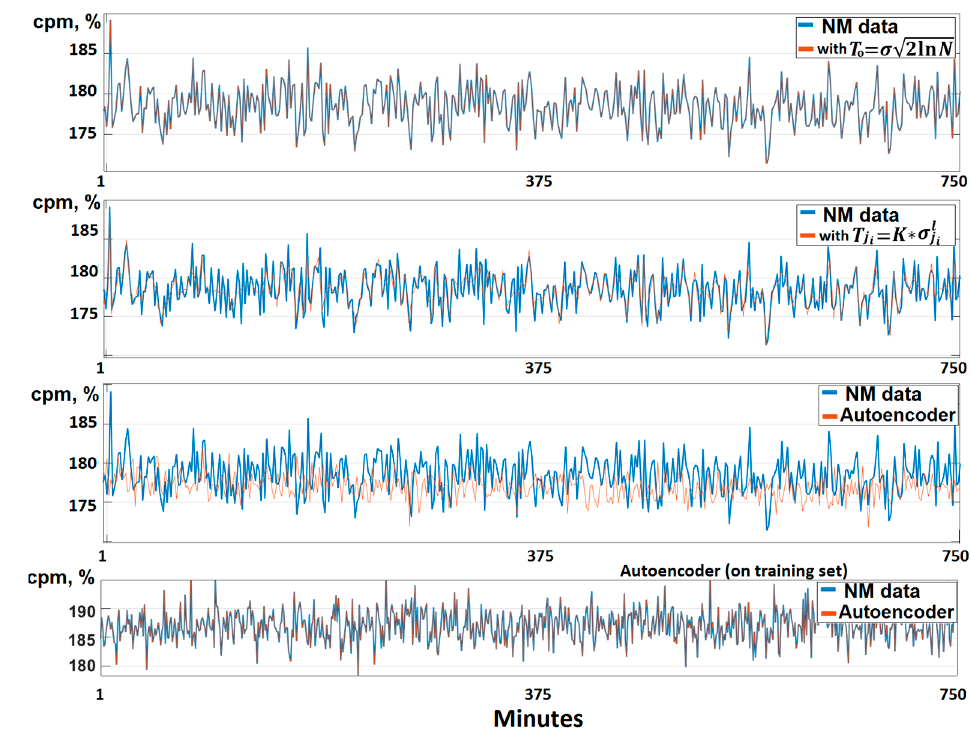
Figure 7. Neutron monitor (NM) data processing results. Table 3. Estimation of the approximation error.